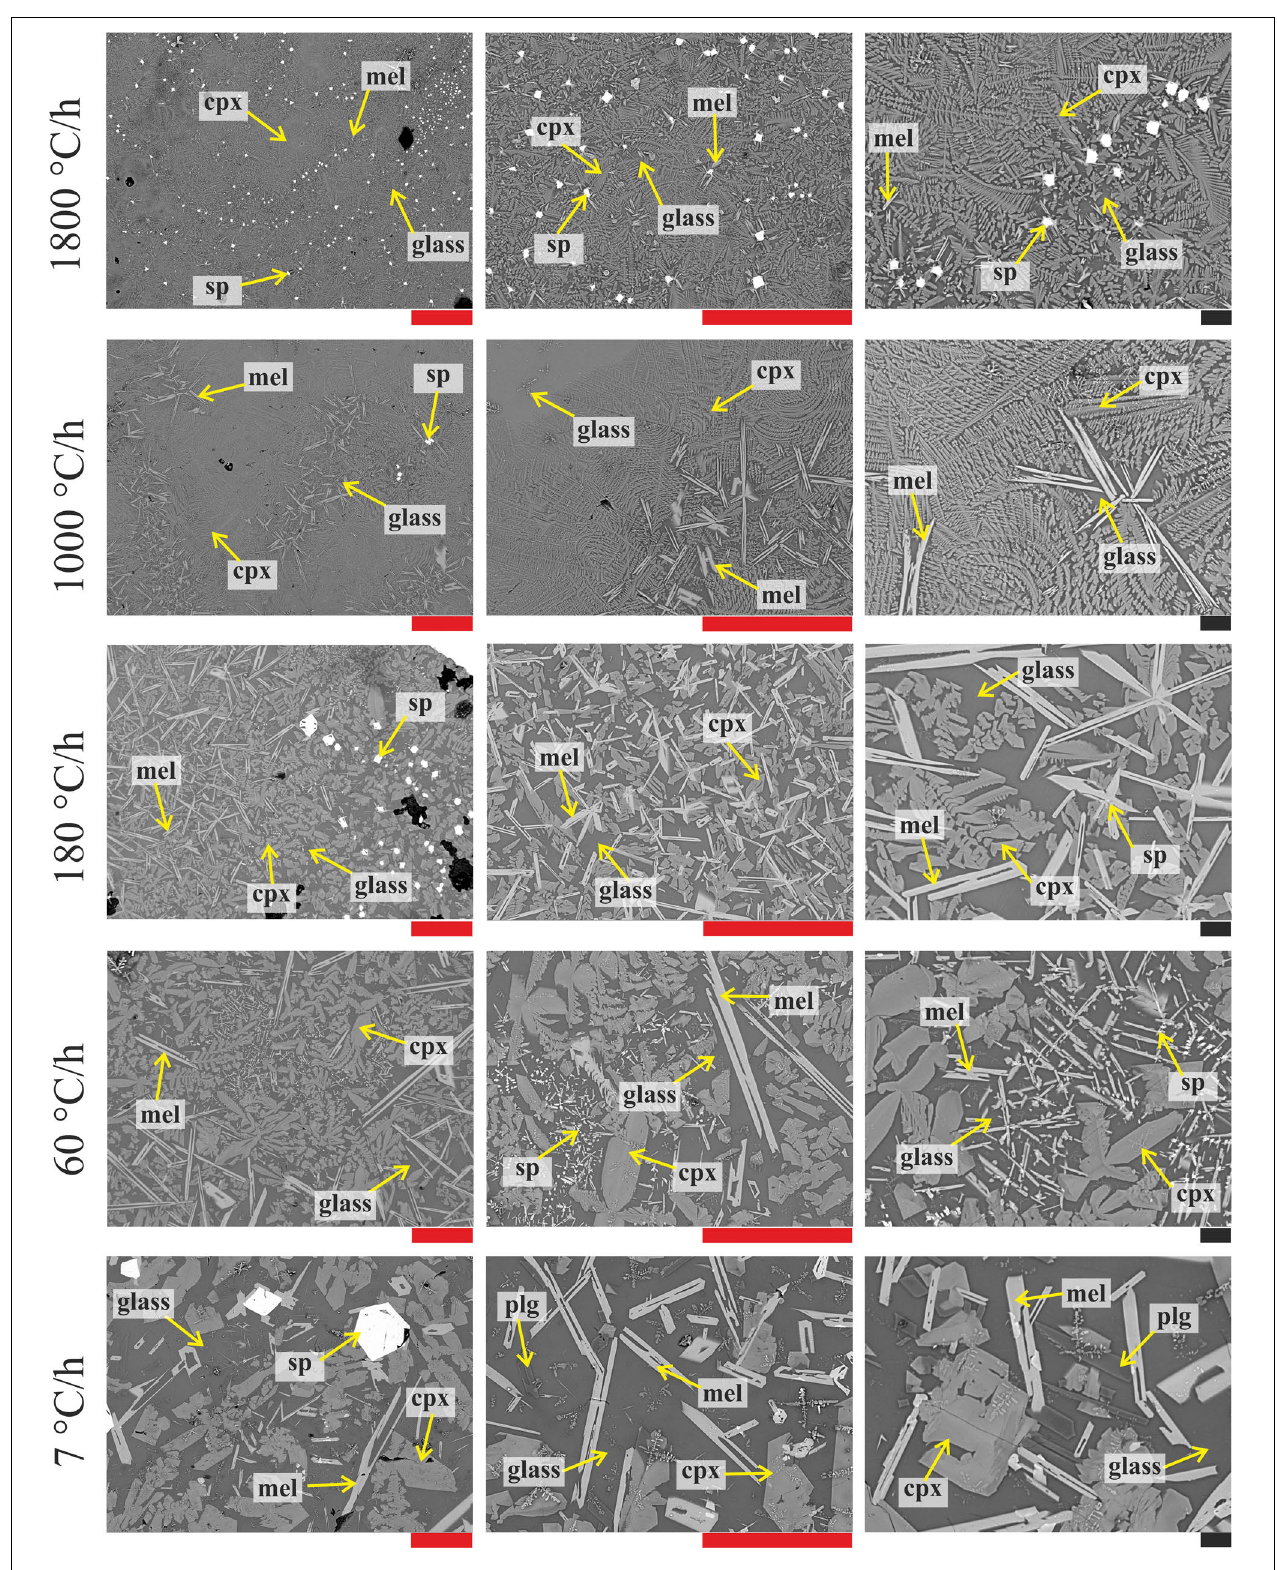
FIGURE 3 | BS-SEM microphotographs of the DSC run products obtained at cooling rates of 7, 60, 180, 1000, and 1800 ◦ C/h (from bottom to top) and magnifications of 200, 500, and 1000X (from left to right). Red and black bars correspond to 100 and 10 µ m, respectively.